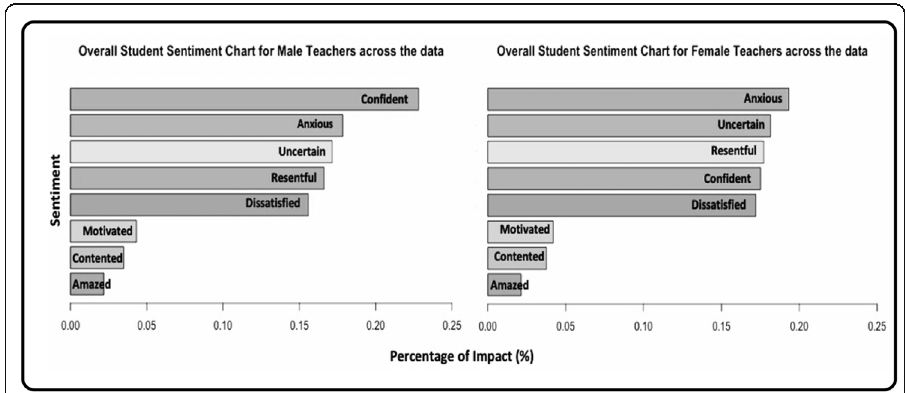
Fig. 9 Sentiments perceived from the comments of the students about their teachers ’ performance, by